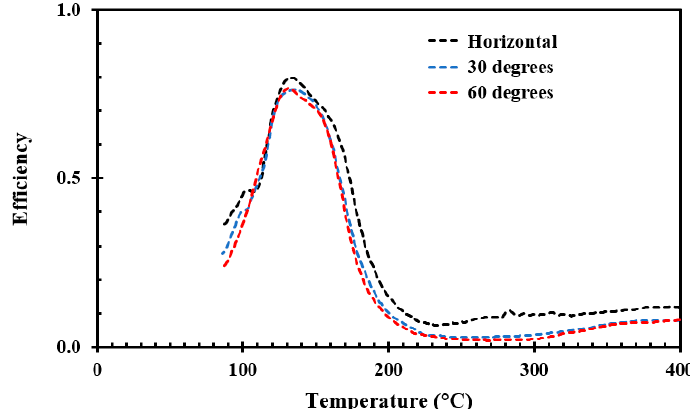
Figure 15. Cooling efficiency for 300 ppm acetone water solution for droplet diameter 2.5 mm, and various orientations at impingement height 25 cm (speed 2.2 m / s).